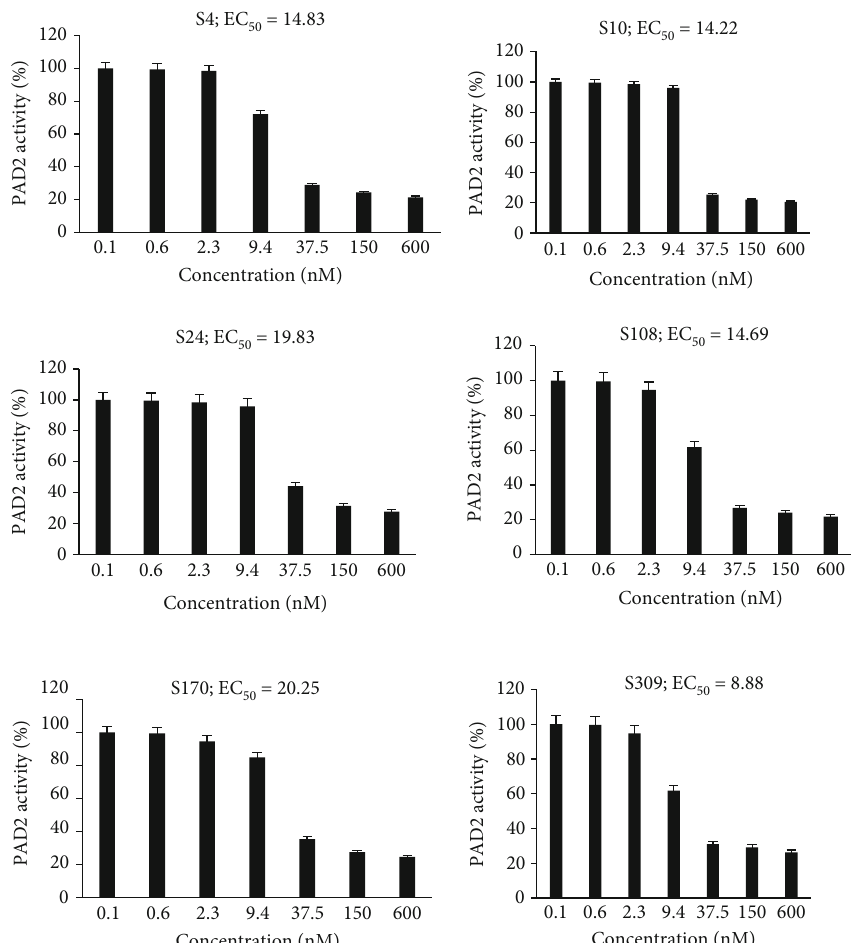
Figure 3: Ability of anti-PAD2 antibodies to inhibit PAD2-mediated citrullination of N α -benzoyl-L-arginine ethyl ester (BAEE). S4, S10, S24, S108, S170, and S309 antibodies were incubated with recombinant human PAD2 (rhPAD2) and bu ff er (20 mM Tris-HCl (pH7.6), 150mM NaCl, and 1mM dithiothreitol) in a total volume of 44 μ L for 30 min at 25 ° C. BAEE and CaCl the mixture was stirred well. The mixture comprised 5 nM rhPAD2, 10mM BAEE, 1 mM CaCl (0.1 – 600 nM). The mixture was incubated at 37 ° C for 4h, and 12.5 μ L of 5M perchloric acid was added to stop the reaction. The level of citrullinated BAEE was determined using a colorimetric assay